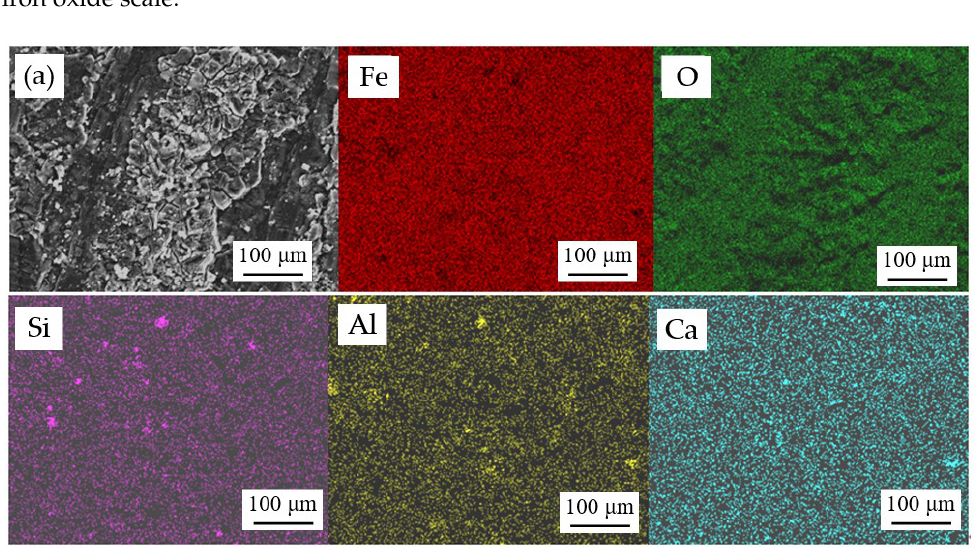
Figure 1. Microscopic morphology and elemental distribution on the surface of iron oxide scales before treatment.